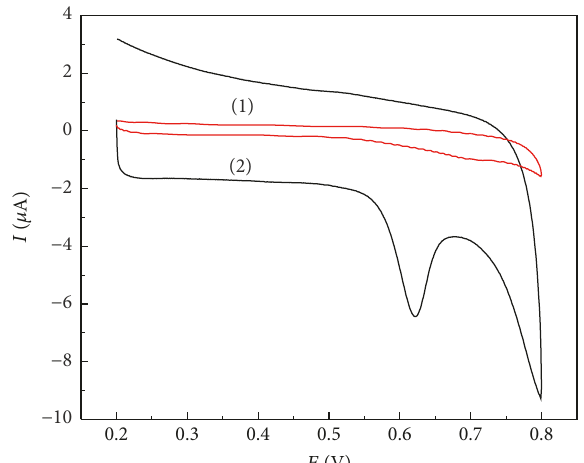
Figure 2: CV curves of 20 𝜇 M trans -resveratrol in 0.04 M BR (pH 2.0) solution at the GC (1) and ERGO/GC (2) electrodes. Scan rate: 25 mVs −1 .